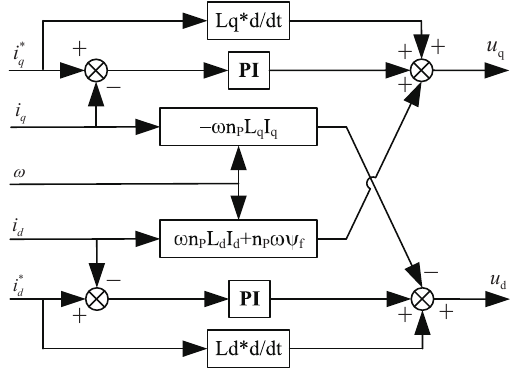
Figure 4. Current control based on the improved PI